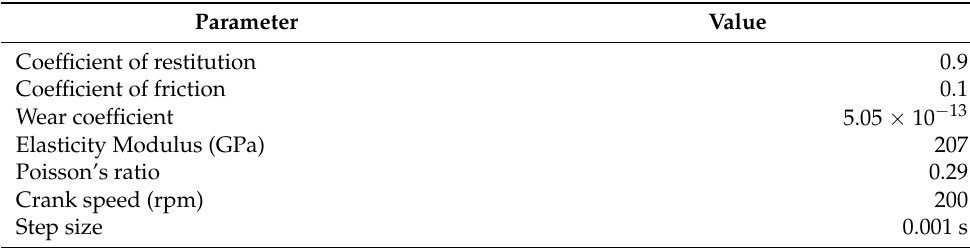
Table 2. Parameters used in the dynamic simulation